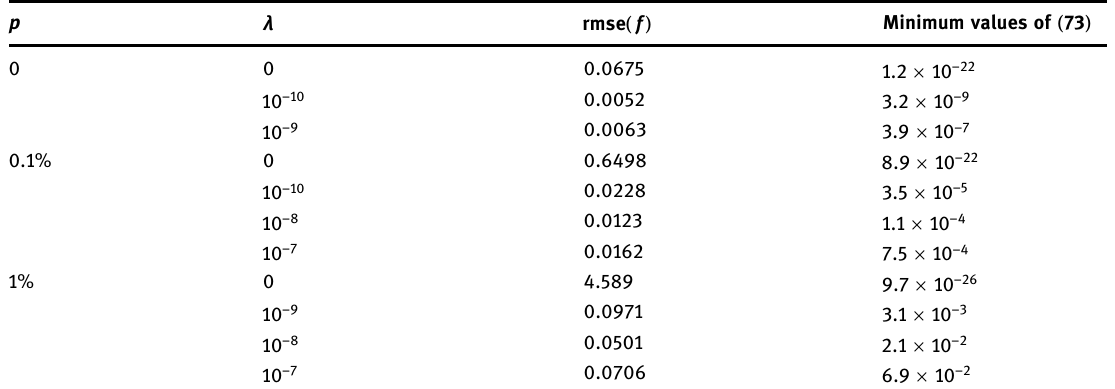
Table 3: The rmse and the least value of ( 73 ) for { } ∈ p 0, 0.1%, 1% , with = λ 10 , 10 , 10 −10 −9 −8 , and 10 −7 at last iteration, for